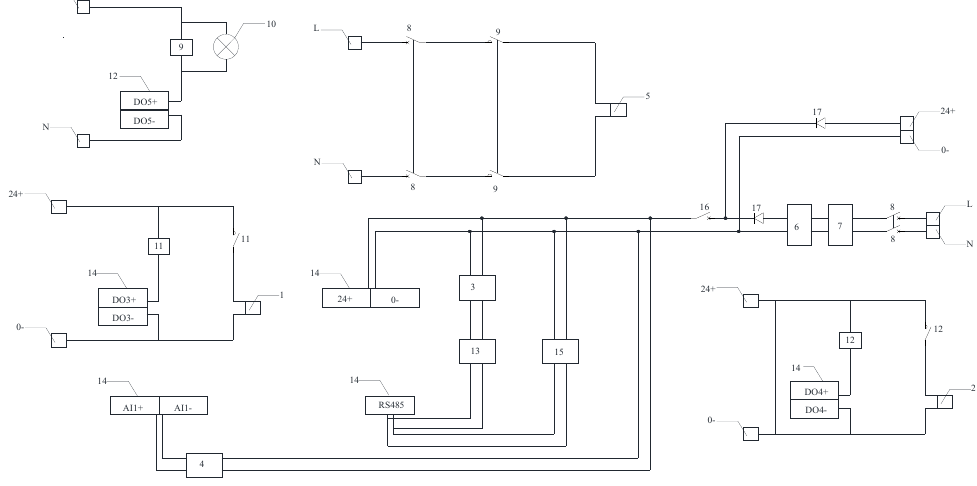
Figure 6. The control circuit of PT thermal utilization. Table 5. The components according to the Figure 6.